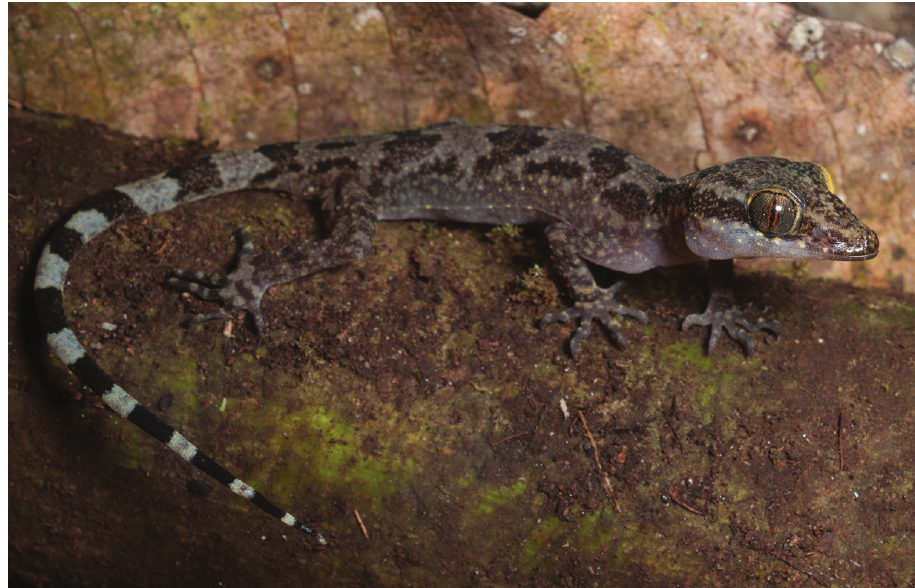
Figure 47. Cyrtodactylus annulatus female (KU 334025) from Eye Falls, Mt. Hilong-hilong, Municipality of Remedios T. Romualdez, Agusan del Norte Province. Photo: RMB.